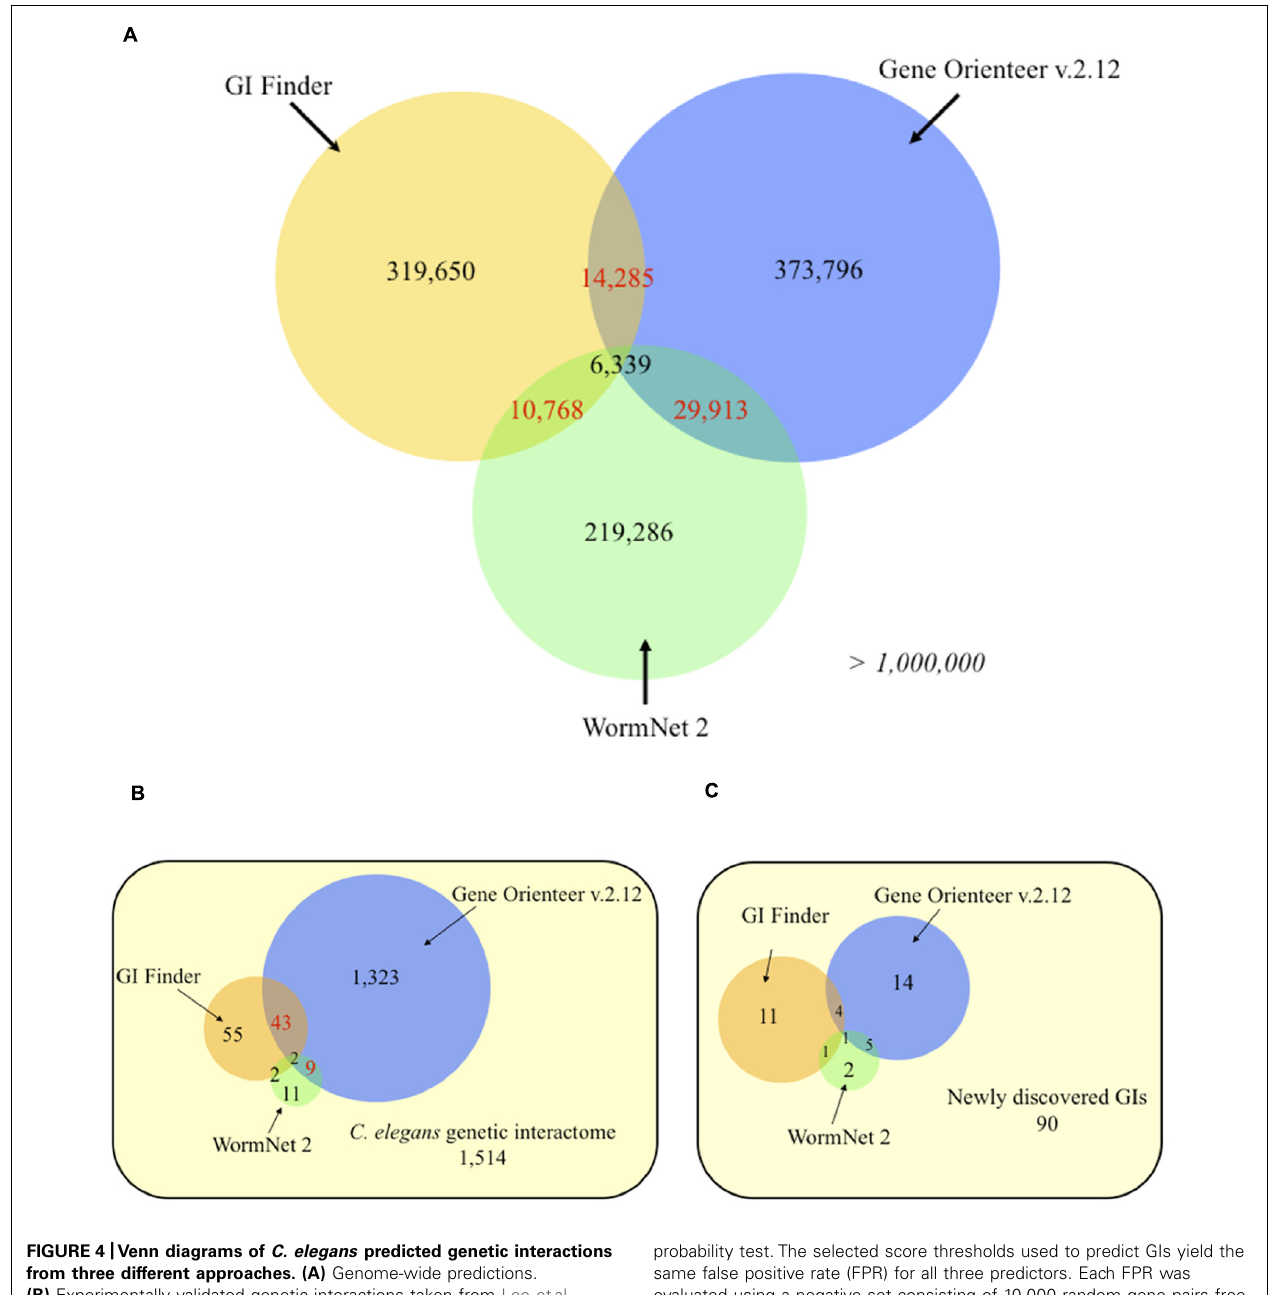
probability test. The selected score thresholds used to predict GIs yield the same false positive rate (FPR) for all three predictors. Each FPR was evaluated using a negative set consisting of 10,000 random gene pairs free of any gene present in validated interactions. Predicted GIs or functional links, for GeneOrienteer and WormNet respectively, were downloaded in October